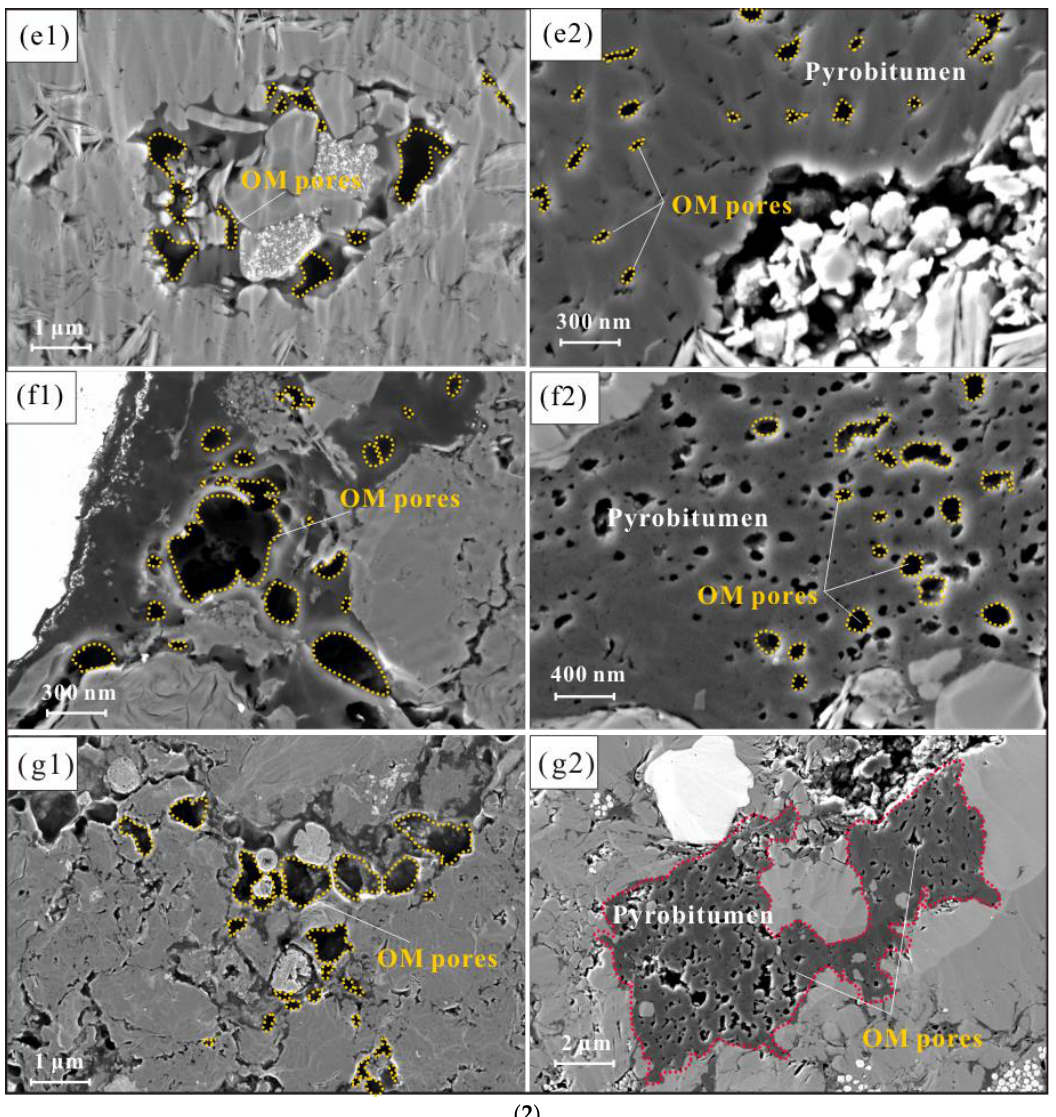
Figure 6. ( 1 ) SEM images of pyrolysis samples at temperatures from 300 to 450 °C. ( 2 ) SEM images of pyrolysis samples at temperatures from 500 to 600 °C. Notes: ( a1 – g1 ) samples based on open system pyrolysis: ( a1 ) micro-fracture in inorganic mineral at 300 °C, R o = 0.68%; ( b1 ) mineral shrinkage pore and interpores at 350 °C, R o = 0.86%; ( c1 ) secondary mineral at 400 °C, R o = 1.23%; ( d1 ) OM pore at 450 °C, R o = 1.61%; ( e1 ) OM pore at 500 °C, R o = 2.01%; ( f1 ) OM pore at 550 °C, R o = 2.58%; ( g1 ) OM pore at 600 °C, R o = 3.09%. ( a2 – g2 ) Samples based on semi-closed system pyrolysis: ( a2 ) dissolved pores and pyrite at 300 °C, R o = 0.69%; ( b2 ) original OM pores developed at 350 °C, R o = 0.89%; ( c2 ) liquid hydrocarbon and microfracture at 400 °C, R o = 1.25%; ( d2 ) there are a large number of OM pores in the pyrobitumen of shale at 450 °C, R o = 1.51%; ( e2 ) OM pores at 500 °C, R o = 1.95%; ( f2 ) OM pores with good connectivity in shale at 550 °C, R o = 2.60%; and ( g2 ) large size OM pore with good connectivity in shale at 600 °C, R o = 3.02%. ( a2 – g2 ) are cited from Fang et al. [21]